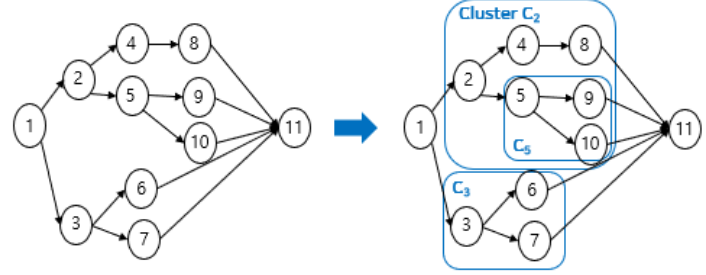
Figure 3. Example of DAG task graph and clusters.